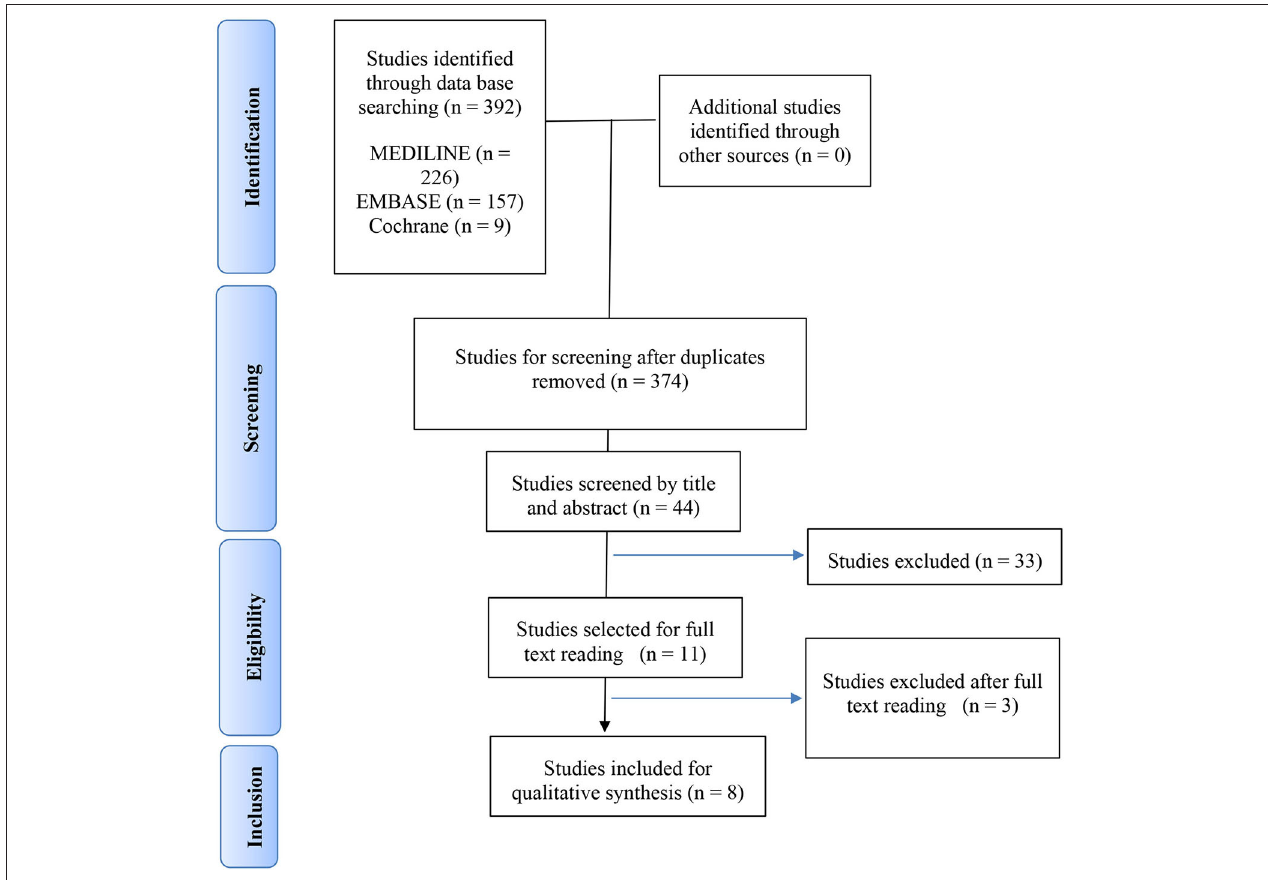
FIGURE 1 | PRISMA flow